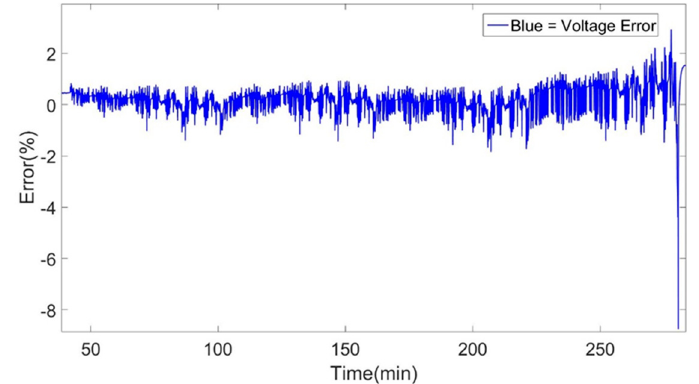
Figure 20. Error of the 2nd order Thévenin model measured and simulated WLTC comparison at 25 °C with Coulomb counting and advanced characterization. Energies 2016 , 9 , 360